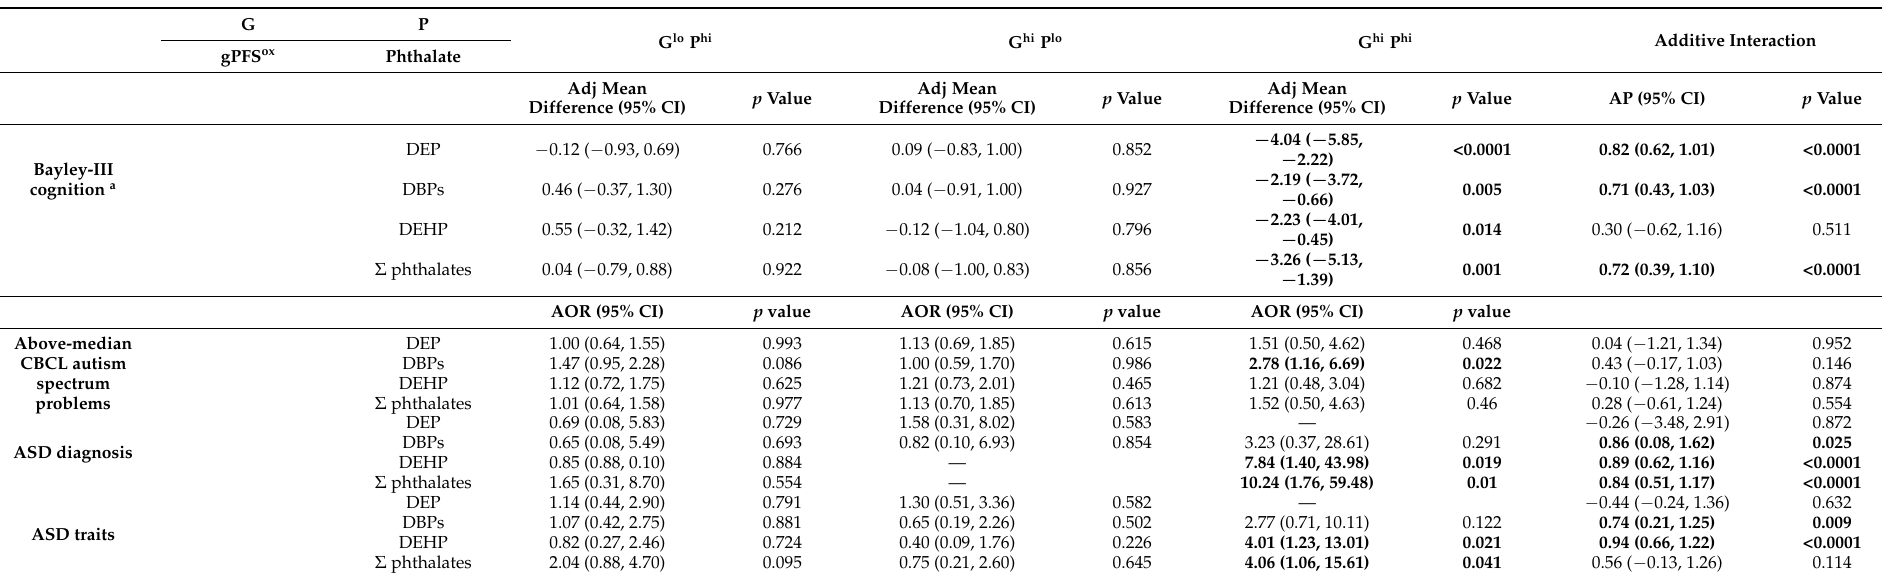
Table 5. Interplay on the additive scale between genetic pathway function score for oxidative stress response (gPFS ox ) and prenatal phthalate levels against neurodevelopmental